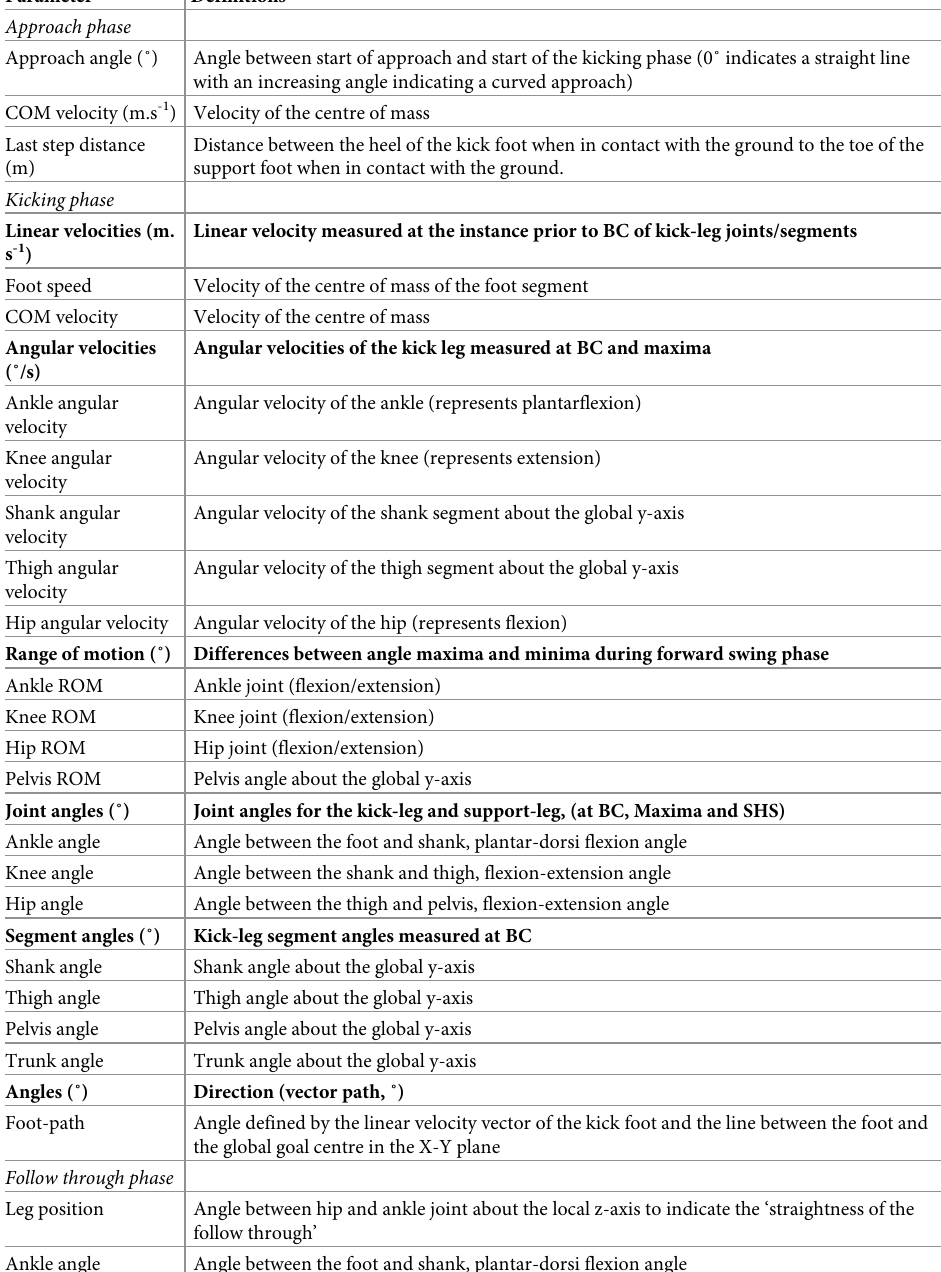
Table 1. Definitions of technical parameters calculated in this study.